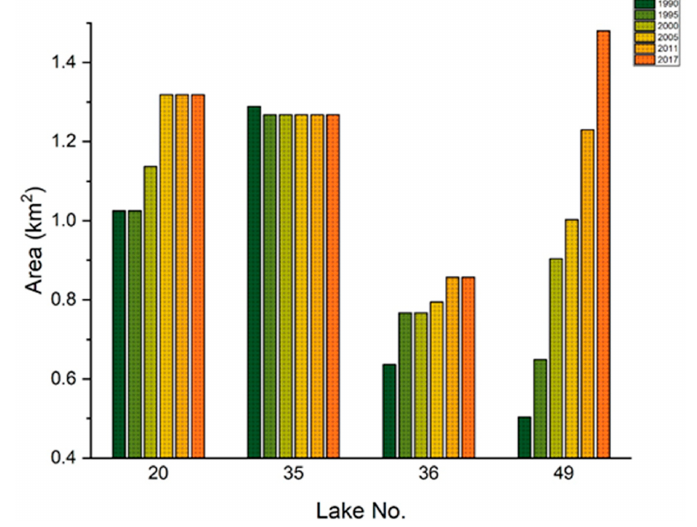
Figure A4. Critical change in area profile of glacial lakes during the period 1990–2018.